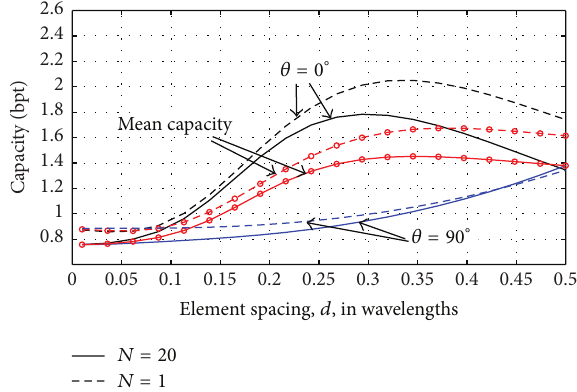
Figure 6: Instantaneous and mean capacity versus element spacing for a pair of receive standard dipoles with self-matching. 𝑁 denotes the number of computational segments on each